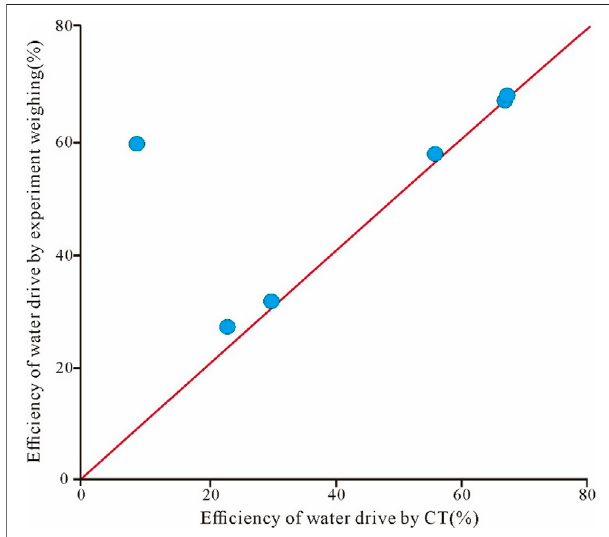
FIGURE 16 | Cross plot of the ef fi ciency of water drive by CT and experiment.